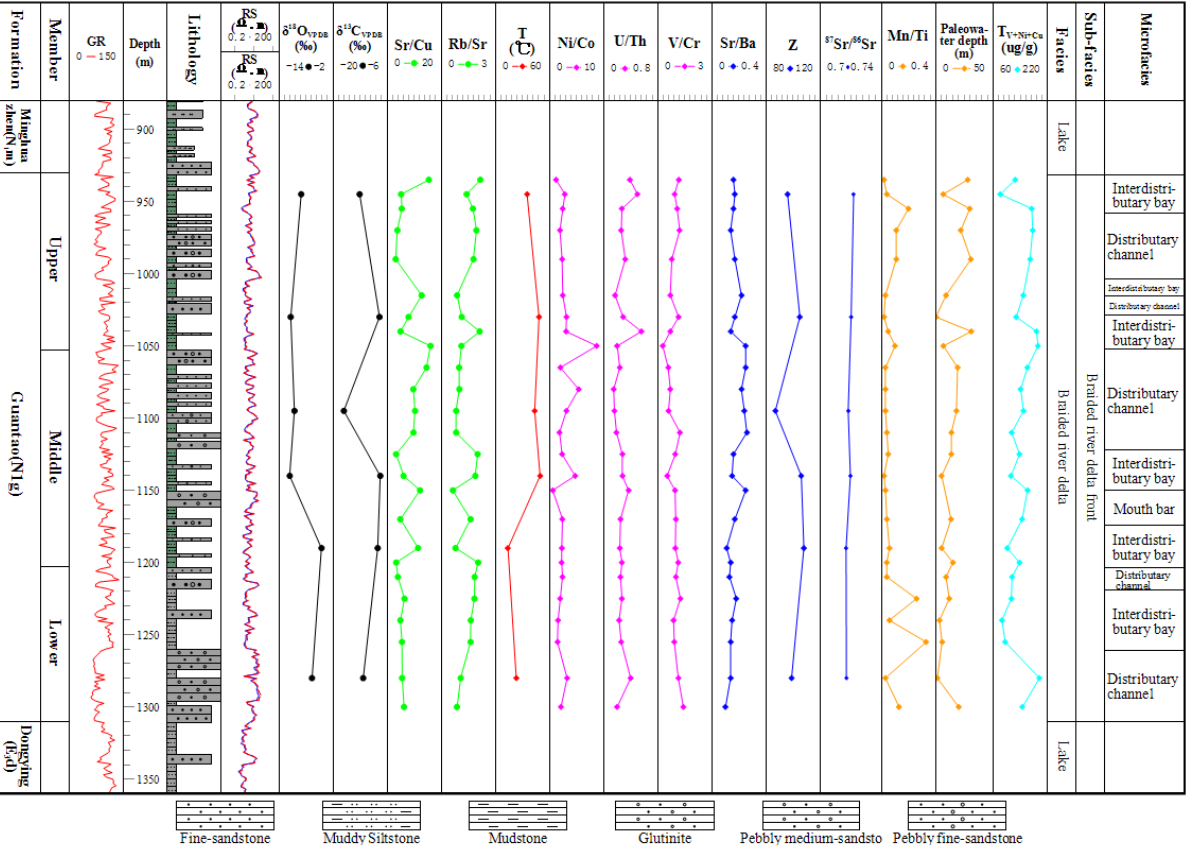
Figure 11. Temporal variations in geochemistry parameters representing paleoenvironment and paleoclimate evolution of the Guantao Formation (Well JZ17).